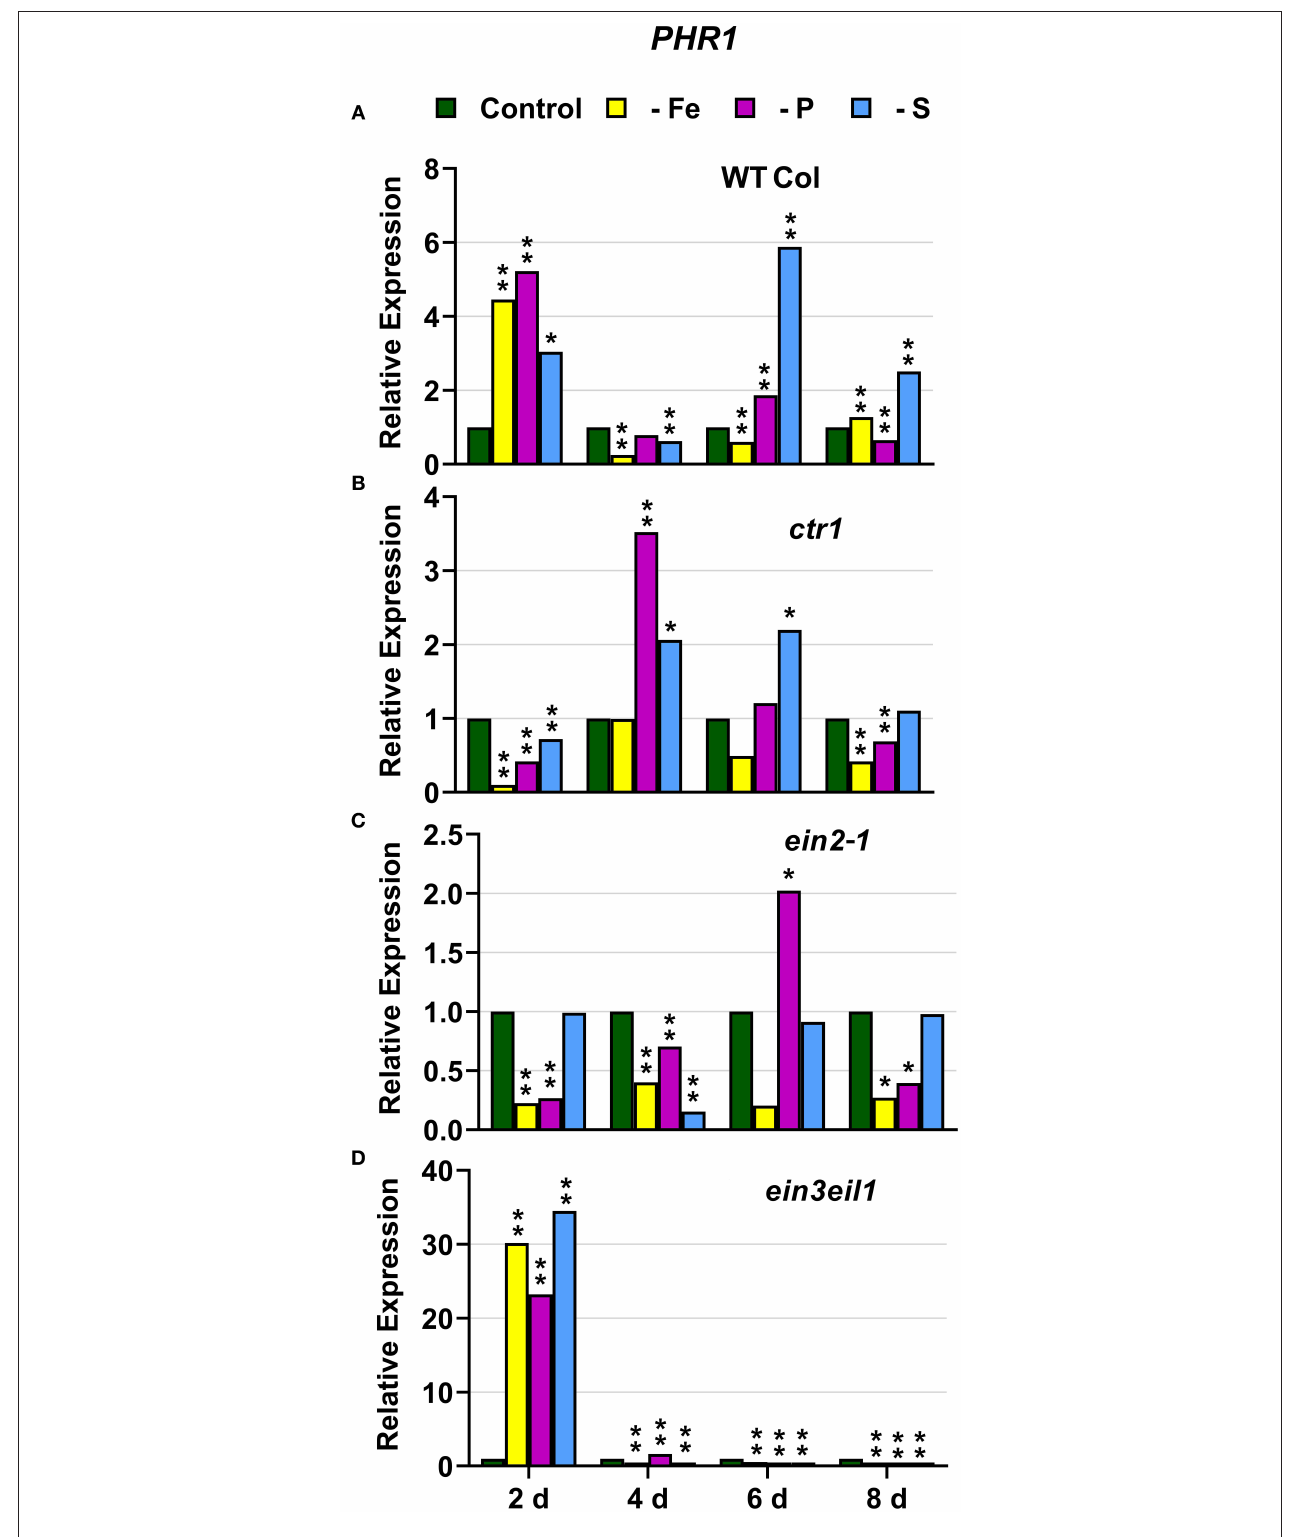
FIGURE 9 | Effect of Fe, P or S deficiency on the expression of the P-related gene PHR1 in roots of the Arabidopsis WT Columbia and its ethylene mutants ctr1 , ein2-1 and ein3eil1 (A–D) . Treatments and gene expression determination as in Figure 1 . Within each day and genotype, * or ** indicate significant differences ( P < 0.05 or P < 0.01) in relation to the control